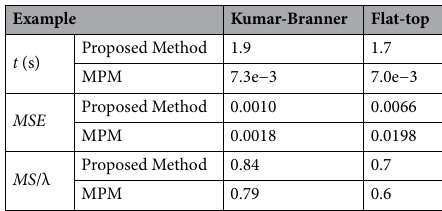
Table 1. Comparison of the proposed and MPM methods.